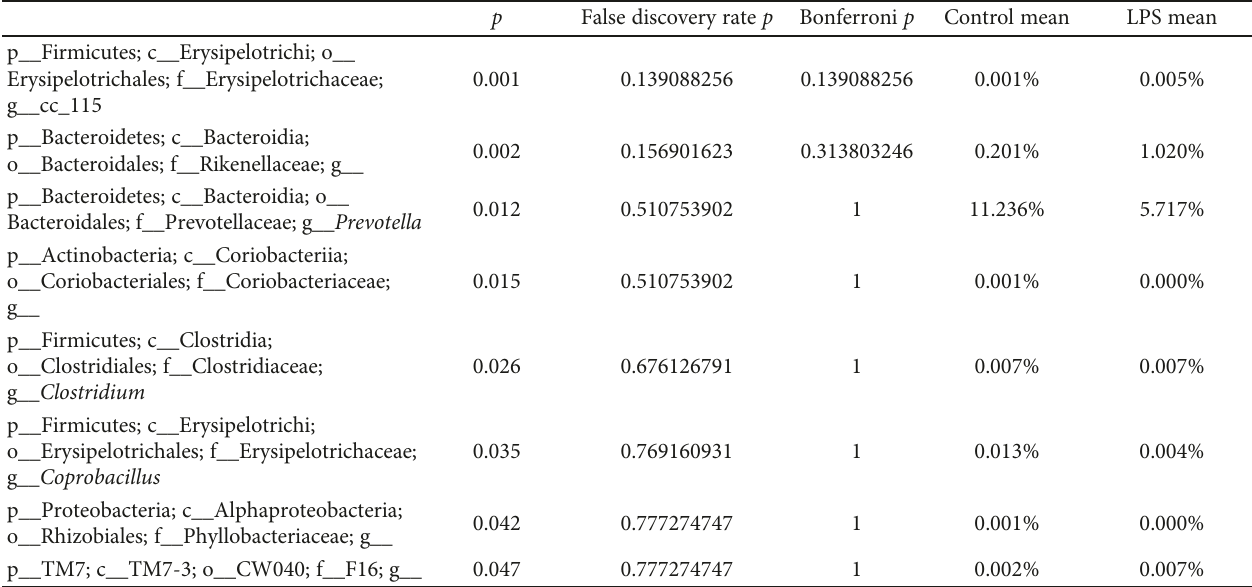
Table 1: Abundances of organisational taxonomic units (OTUs) signi fi cantly di ff erent in the gut microbiota of C57BL/6NTac mice orally fed with lipopolysaccharides (LPS) for four weeks after birth. P: Phylum; c: class; o: order; f: family; g: genus.